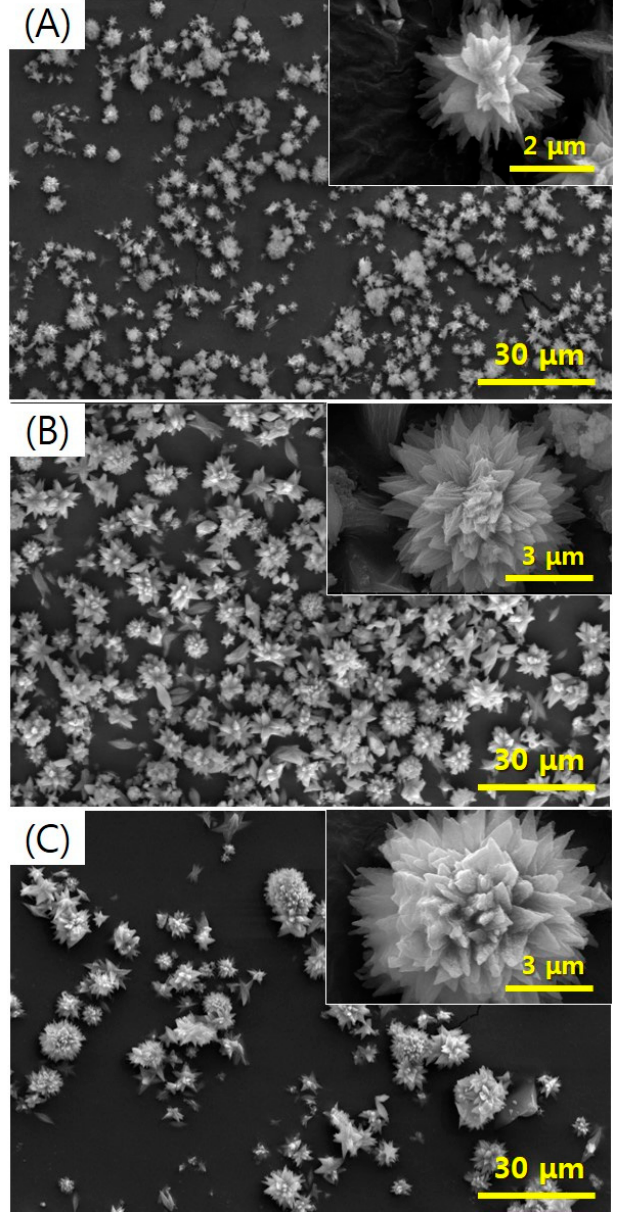
Figure 2. SEM images for samples synthesized at different aging times without organic acids. ( A ) 1 h, ( B ) 2 h, and ( C ) 6 h.